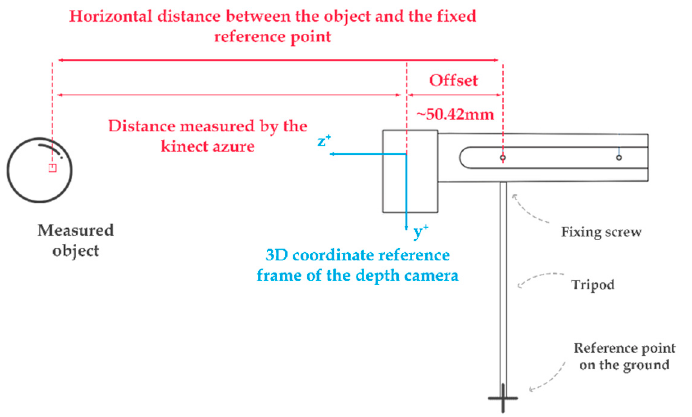
Figure 11. Schema of the difference between the distance measured by the Kinect and the true horizontal distance from a point on the